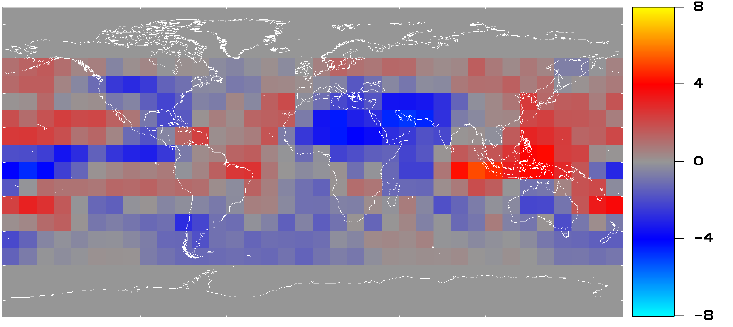
Figure 9. ERBS WFOV Outgoing Longwave Radiation long-term change from 1985–1990 to 1991–1997.